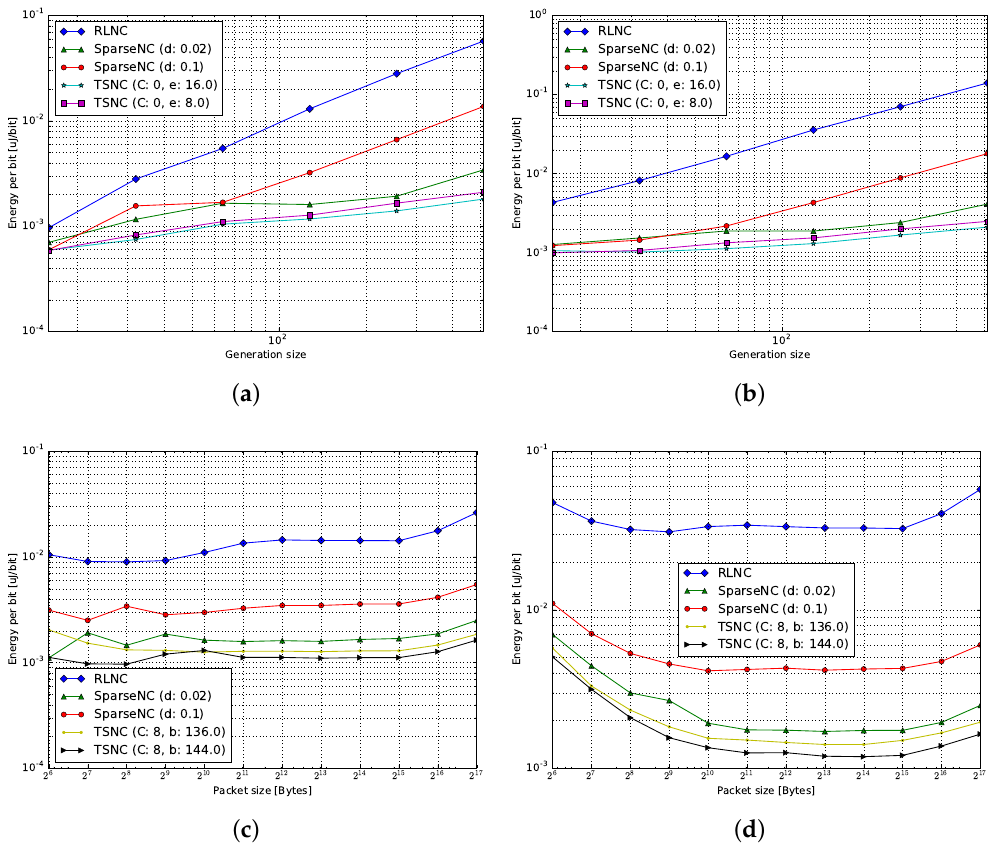
Figure 9. Encoder energy measurements for the Raspi 1. ( a ) Energy per bit vs. generation size for q = 2; ( b ) energy per bit vs. generation size for q = 2 8 ; ( c ) energy per bit vs. packet size for q = 2, g = 128; ( d ) energy per bit vs. packet size for q = 2 8 , g = 128.